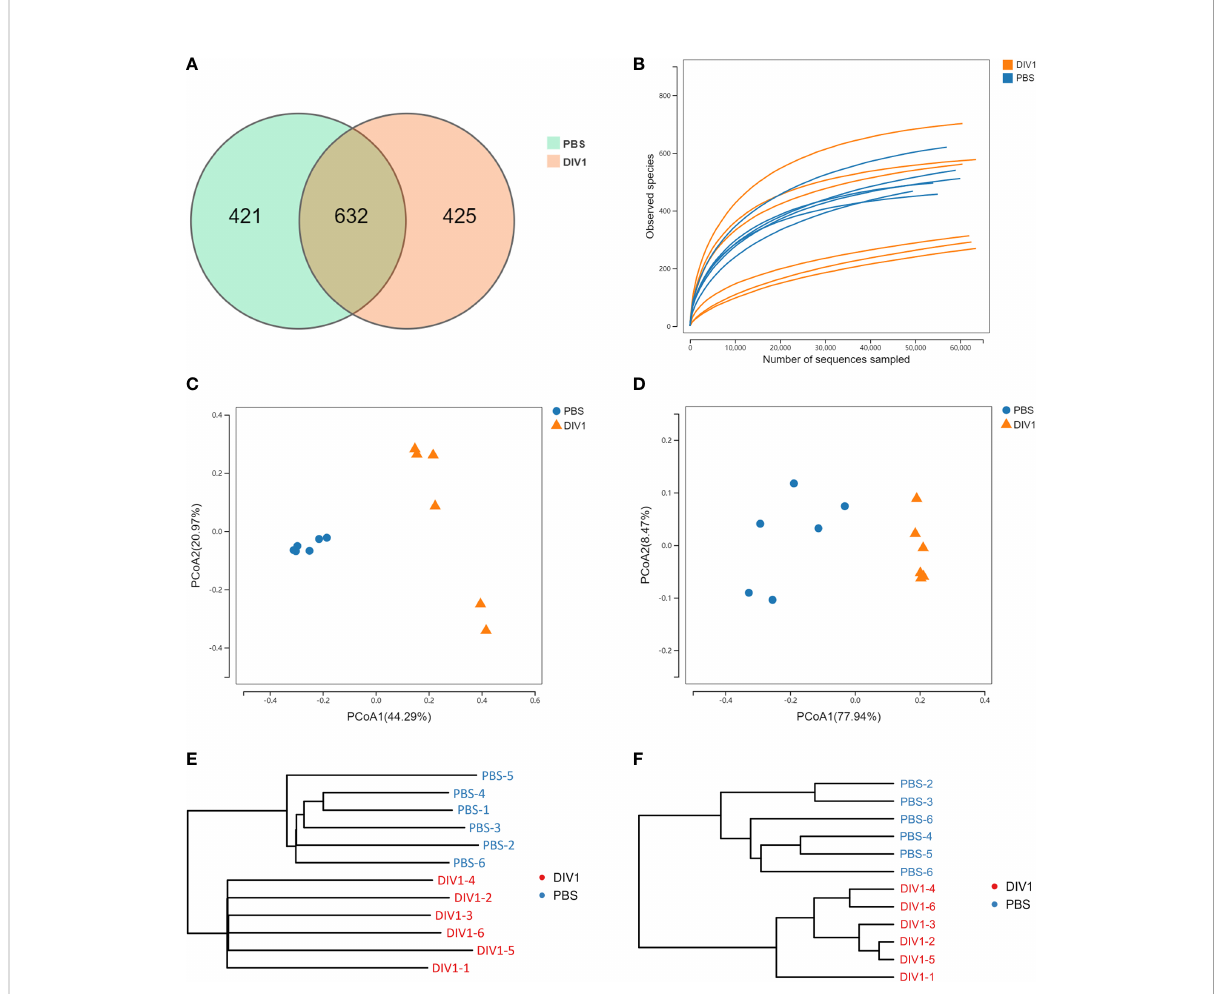
FIGURE 3 Intestinal microbial richness and diversity of M. japonicus after DIV1 infection. (A) Veen diagram showing the unique and shared OTUs of intestinal microbiota in the PBS-injected group and the DIV1-infected group. (B) Rarefaction curves of OTUs clustered at 97% sequence identity different samples. (C) PCoA plot with unweighted unifrac distance. (D) PCoA plot with weighted unifrac distance. (E) UPGMA Phylogenetic Dendrogram with unweighted unifrac distance. (F) UPGMA Phylogenetic Dendrogram with weighted unifrac